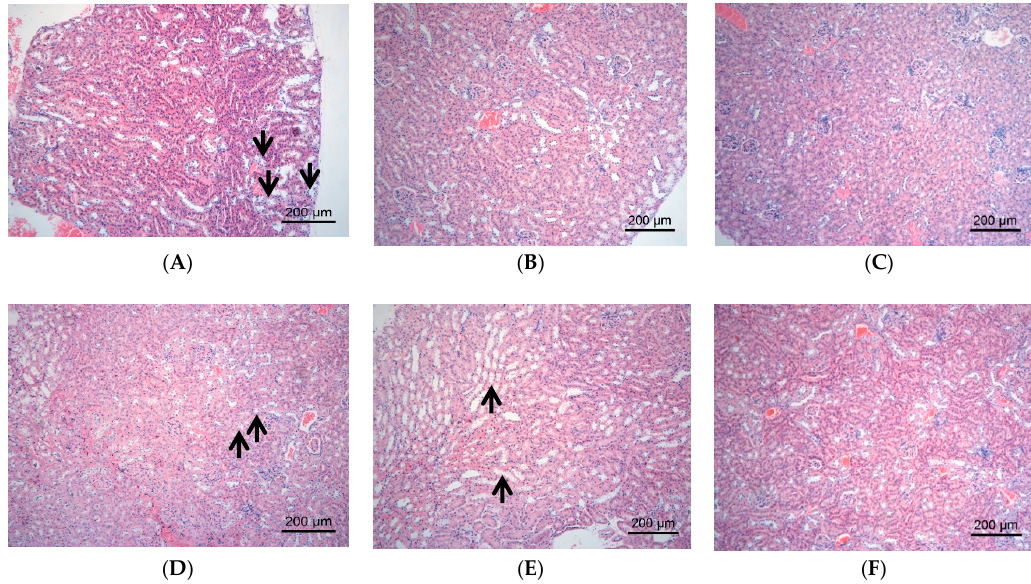
Figure 4. The pathological changes of kidney tissues observed under light microscope. The representative areas of vacuolar degeneration of renal tubular epithelial cells were indicated via black arrow, which appeared foam-like under light microscope. ( A ) DM group, vacuolar degeneration of renal tubular epithelial cells by approximately 21–40%; ( B ) DMMET130 group, normal renal cortex and medulla; ( C ) Control group, normal renal cortex and medulla; ( D ) DMDJP25 group, vacuolar degeneration by approximately 21–40%; ( E ) DMDJP50 group, vacuolar degeneration less than 20%; ( F ) DMDJP100 group, normal renal cortex and